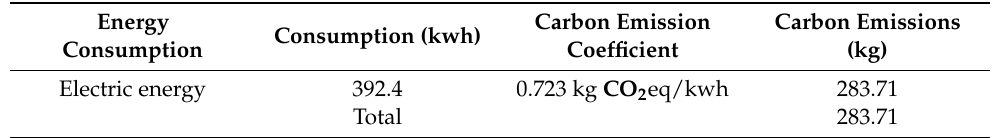
Table 7. Carbon emissions generated by electric energy consumption during the installation stage of CG-2 composite